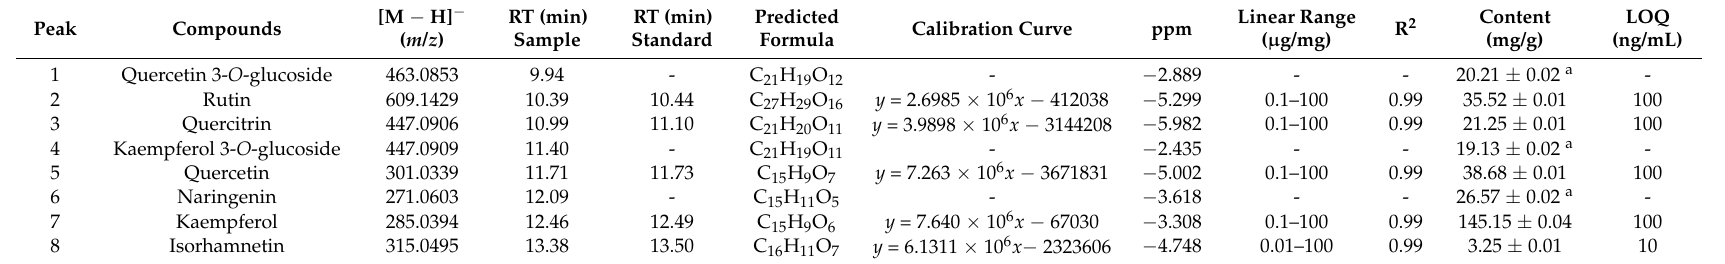
Table 1. The retention time and fragment ions of each compound in RBP extract and